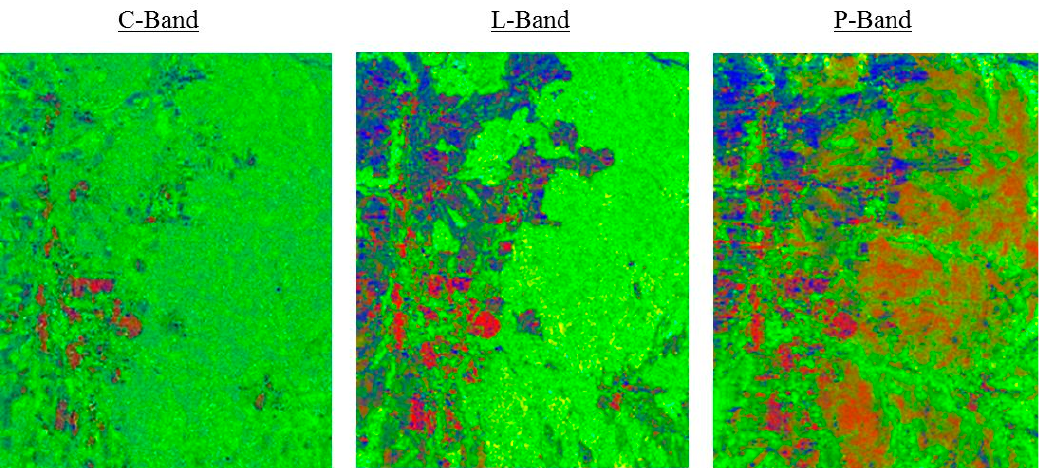
Figure 3. Results of the Freeman algorithm applied to three di ff erent wavelength images in Freiburg obtained by AIRSAR. From left to right, C-band (5 cm), L-band (24 cm) and P-band (68 cm) images are displayed. Green, red and blue are assigned to volume scattering, double-bounce scattering and ground scattering, respectively [21].